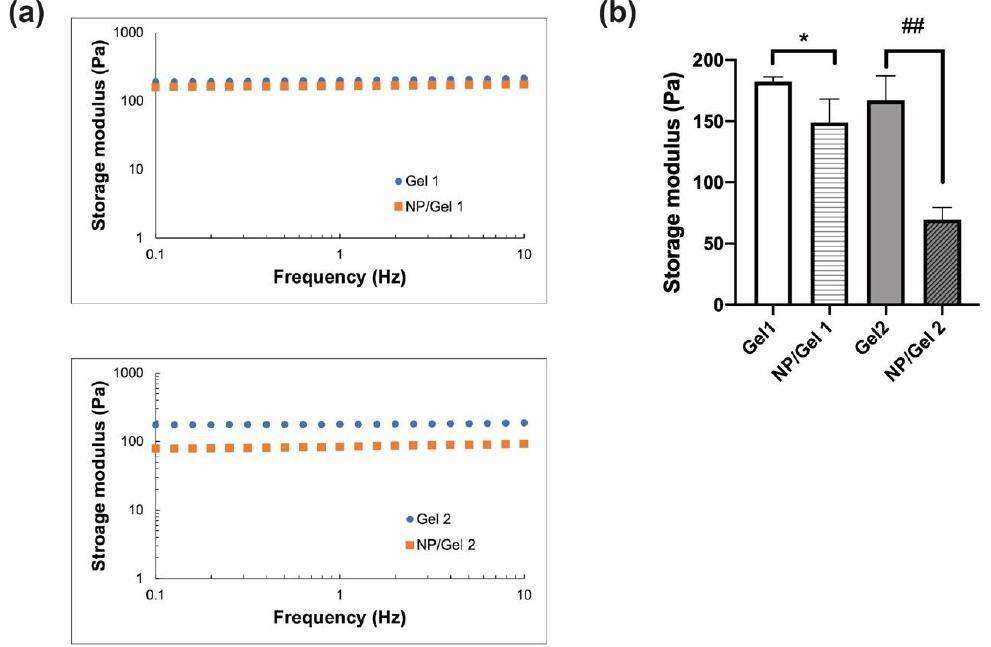
Figure 4. ( a ) Unconfined compression measurements of Gels and nanoparticle (NP)/Gel composites with oscillation frequency ranging from 0.1 to 10 Hz at 5% strain at 37 °C ( n = 3). ( b ) The storage moduli of the Gels and their respective NP/Gel composites obtained at 5% strain and 1 Hz frequency ( n = 3). Statistical analysis comparing between Gels and their respective NP/Gel composites, * p < 0.05, ## p < 0.01.